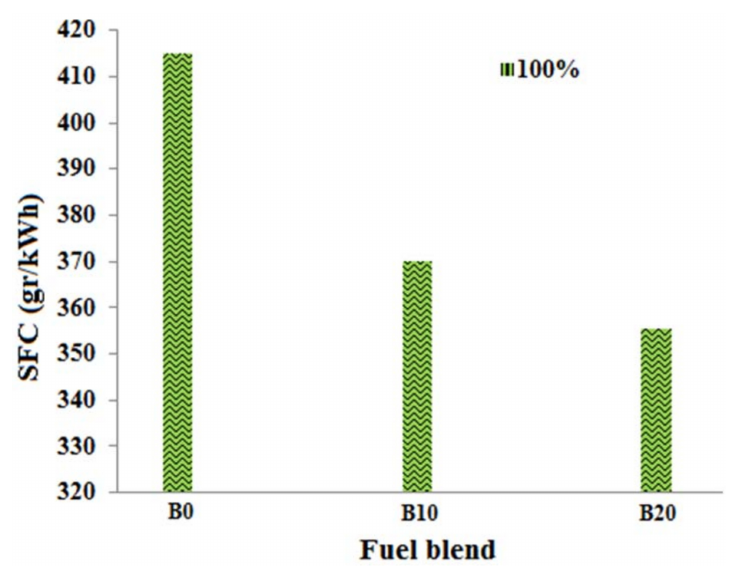
Figure 6. Results of specific fuel consumption (SFC) for different fuel blends at the constant speed of 2100 rpm.